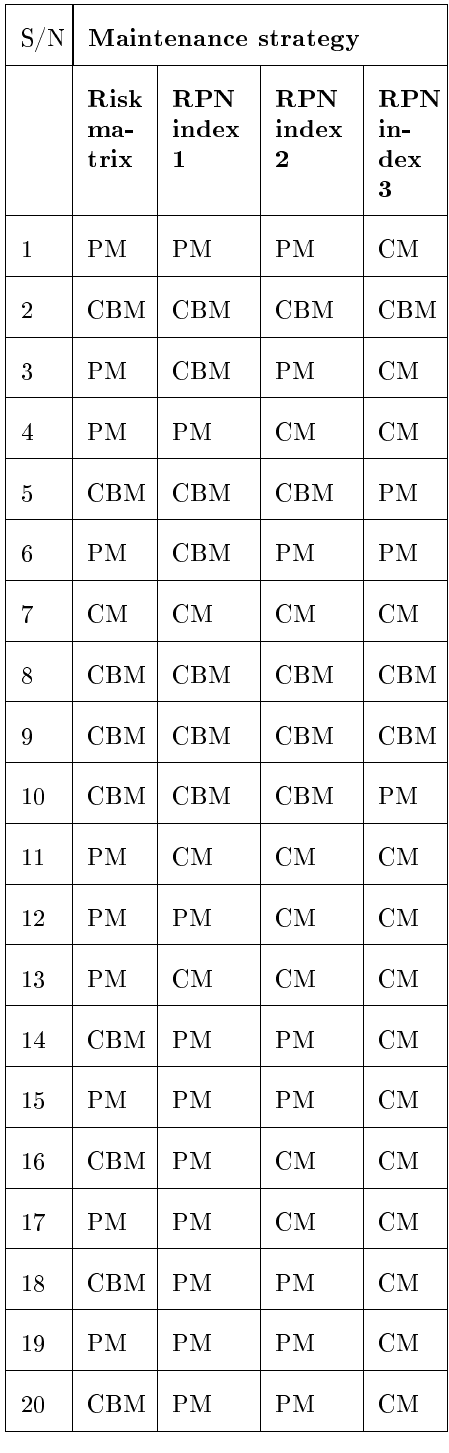
Tab. 16: Comparison of methods based on failure modes assigned maintenance